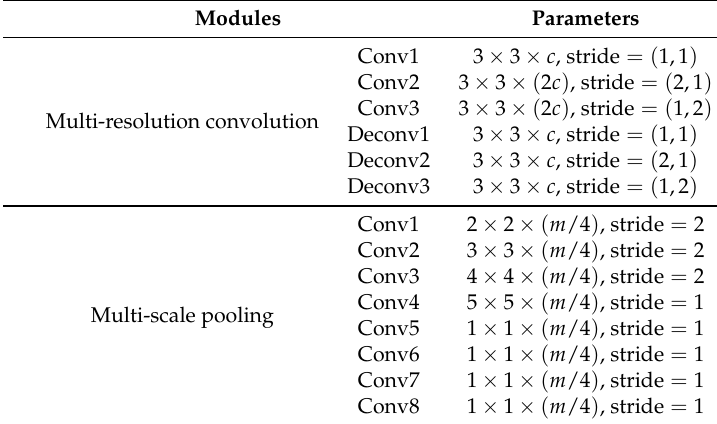
Table 4. Some key parameters in the nodule determination sub-network ( m and c represent the channels of the corresponding former